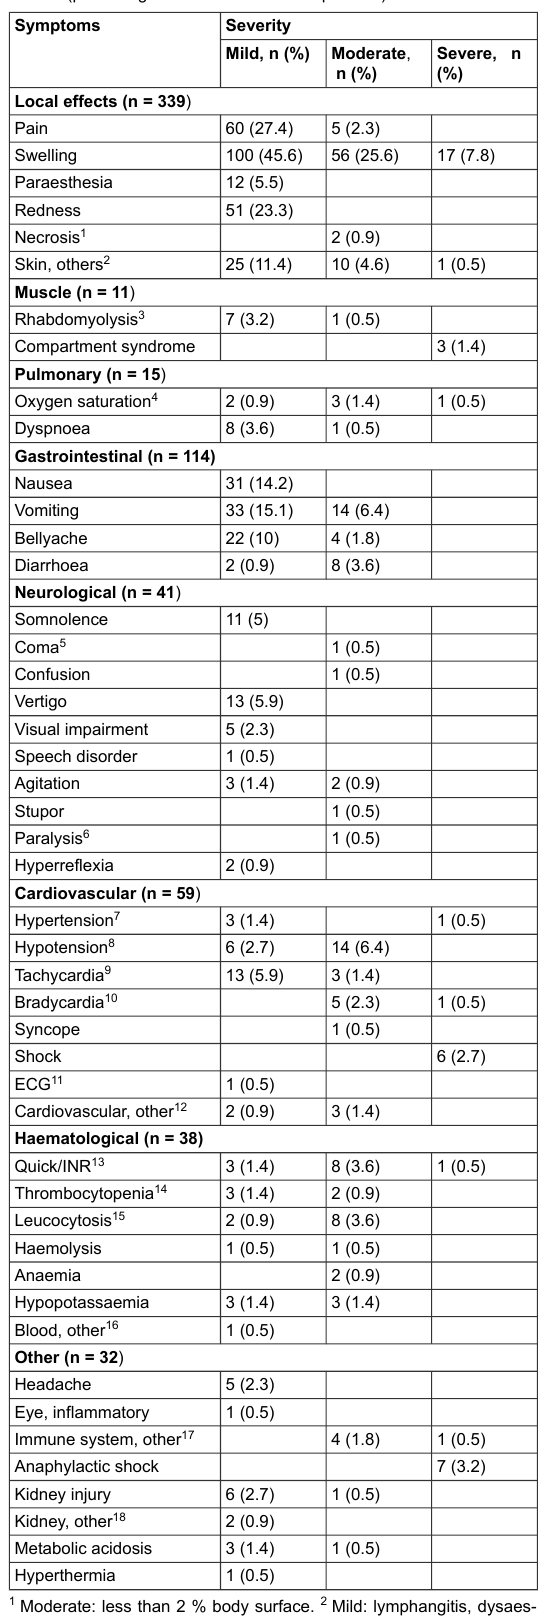
Table 3: The 625 symptoms reported in 219 patients after bites by indigenous snakes (percentages calculated from 219 patients).